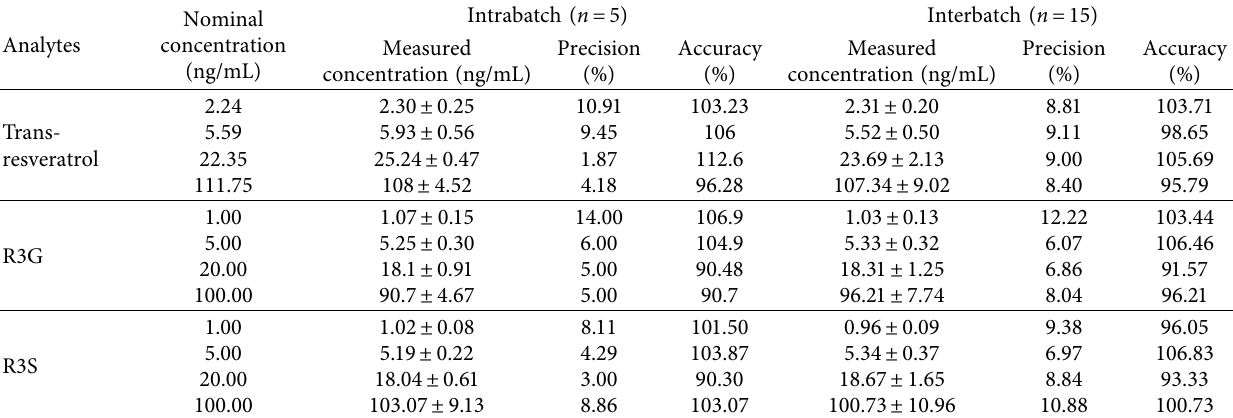
Table 2: Intrabatch ( n � 5) and interbatch ( n � 15) accuracy and precision of trans-resveratrol, R3S, and R3G in mice blood at four QC levels. Nominal Analytes concentration Trans- resveratrol